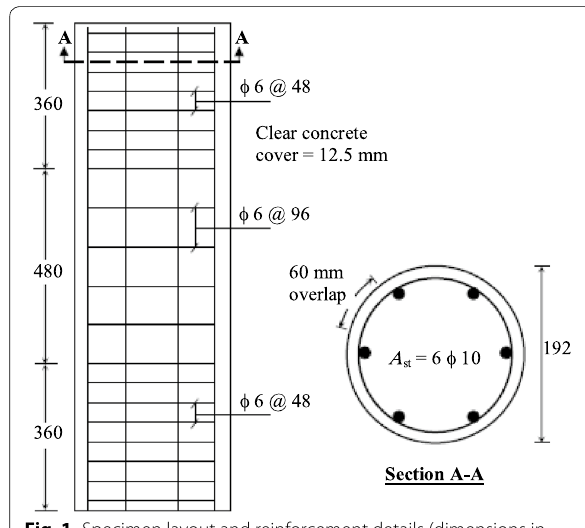
Fig. 1 Specimen layout and reinforcement details (dimensions in